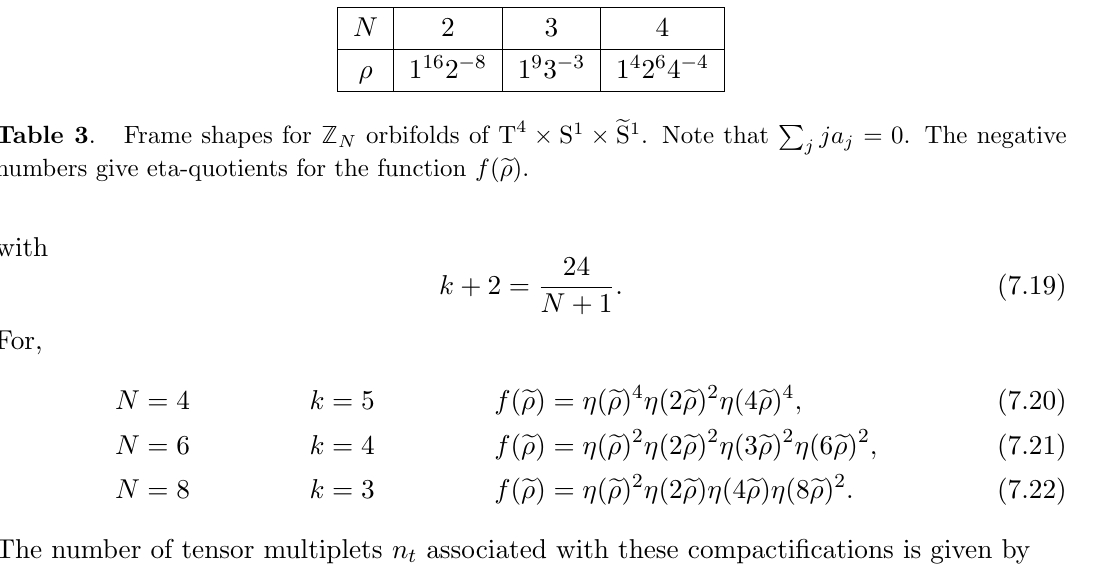
table 1. This uniform value of discussed